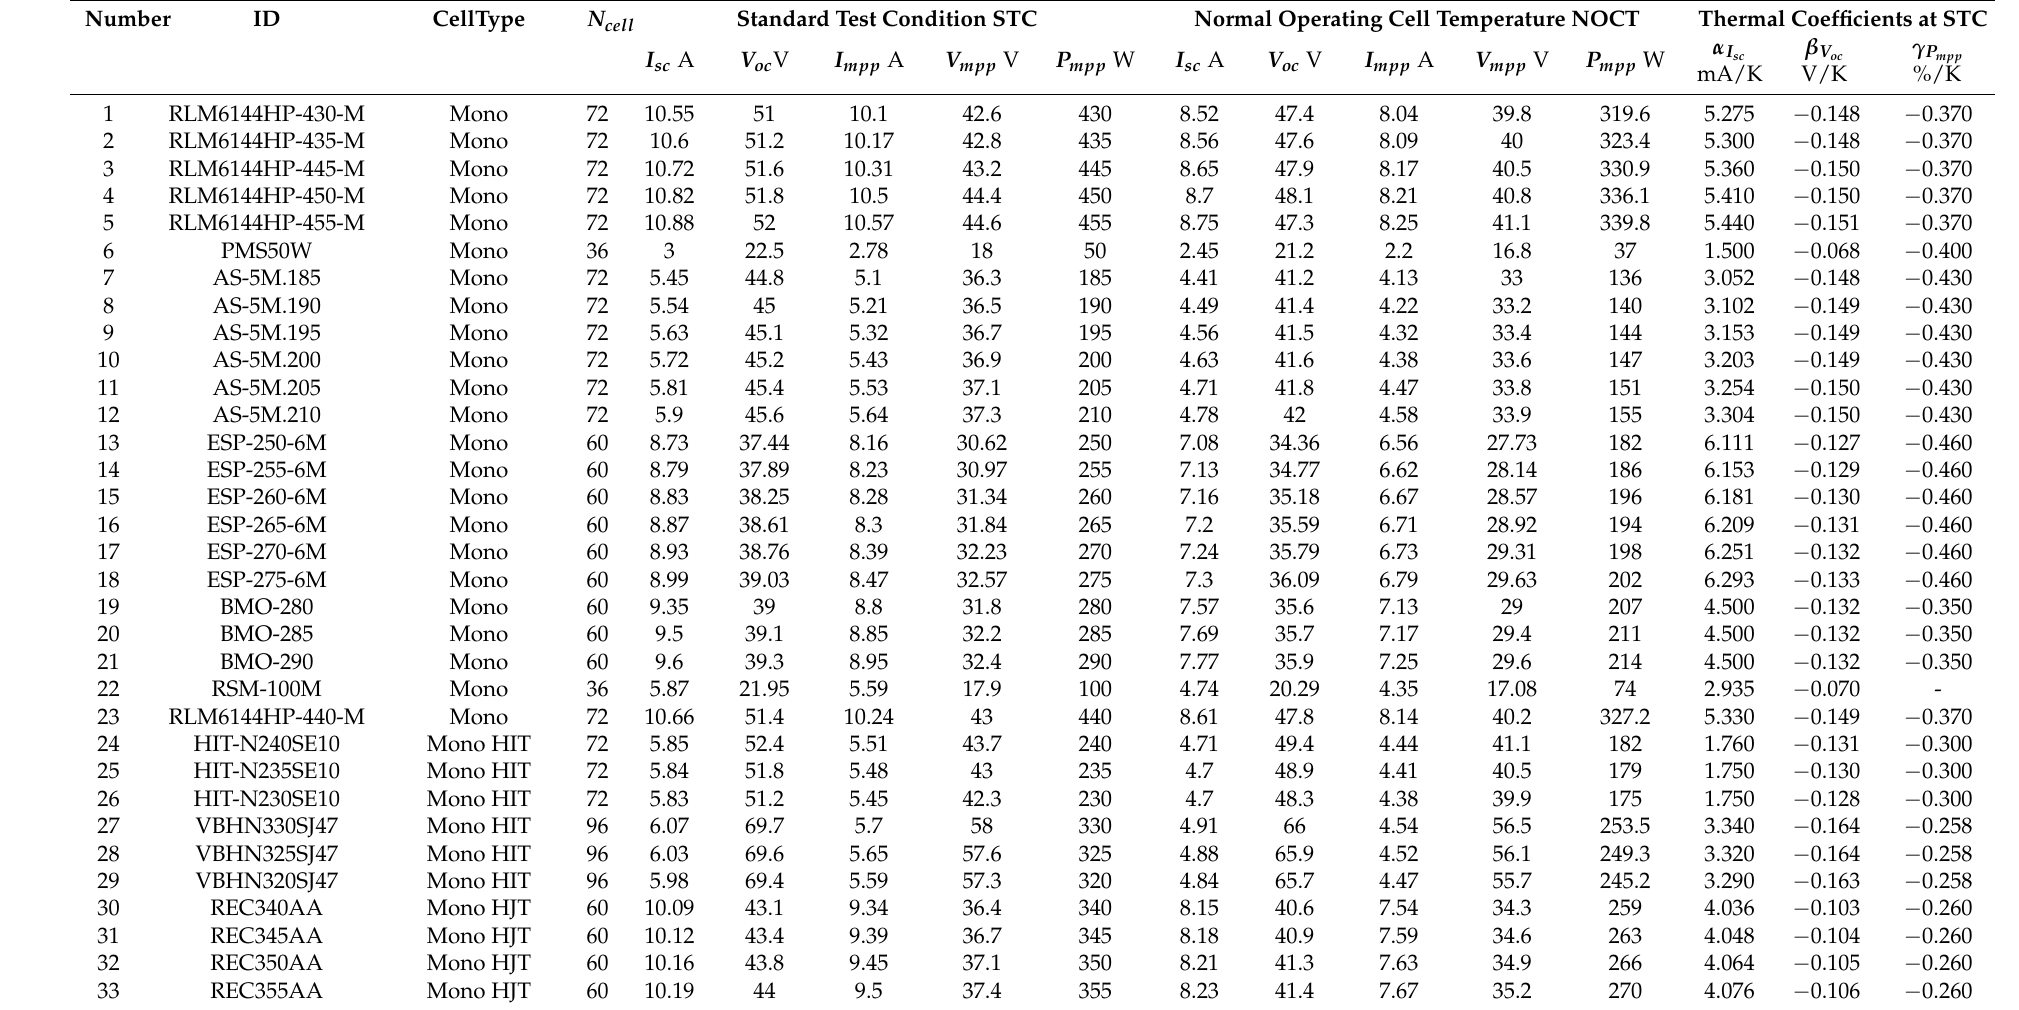
Table A1. STC and NOCT electrical parameters corresponding to the SPVM used in results